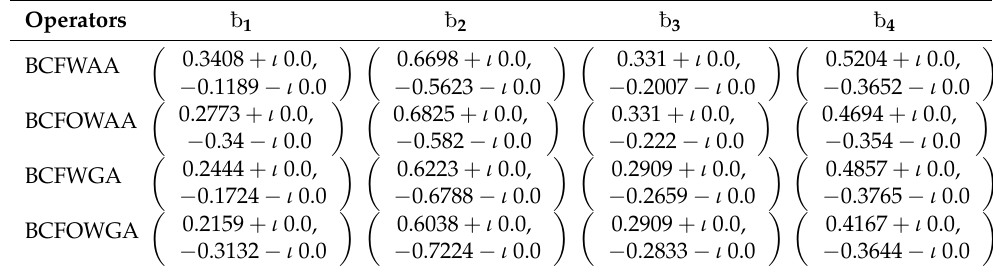
Table 6. Expression of the aggregated values.